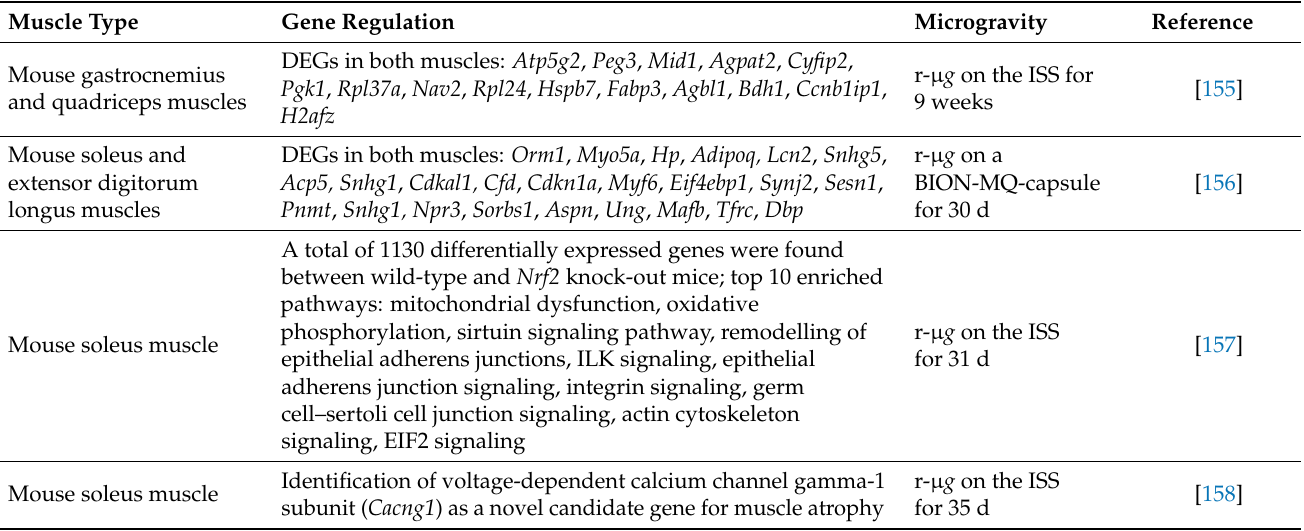
Table 7. Changes in gene regulation of muscle exposed to microgravity